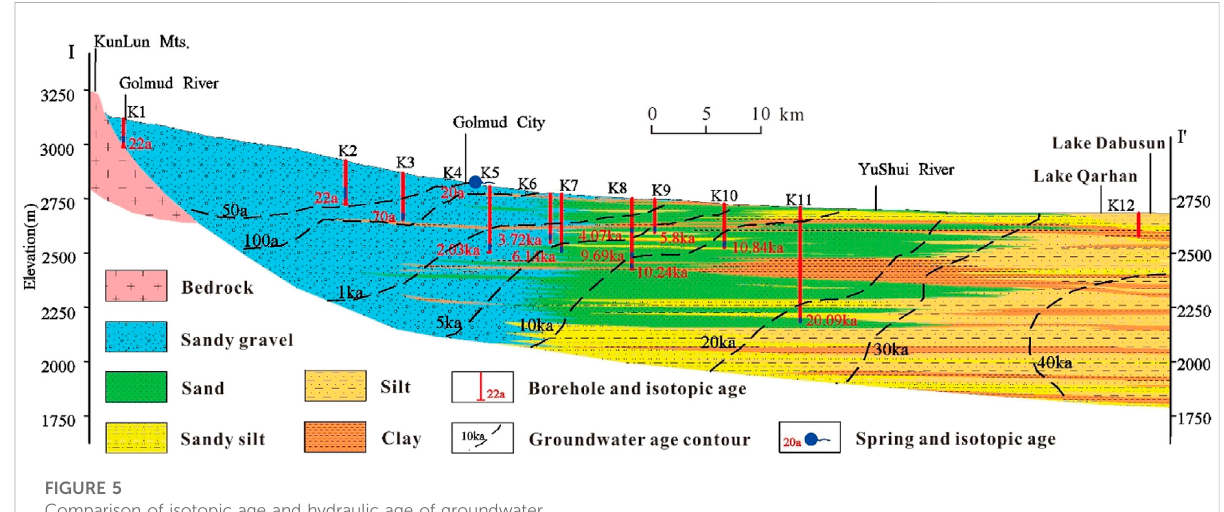
FIGURE 5 Comparison of isotopic age and hydraulic age of